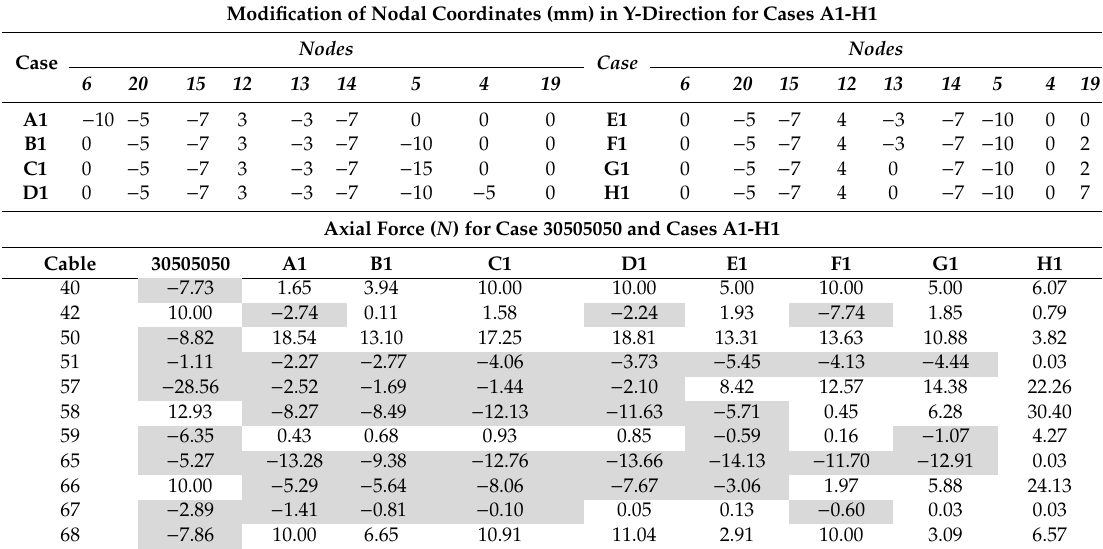
Table 1. Axial forces in SB1 for cases A1–H1.